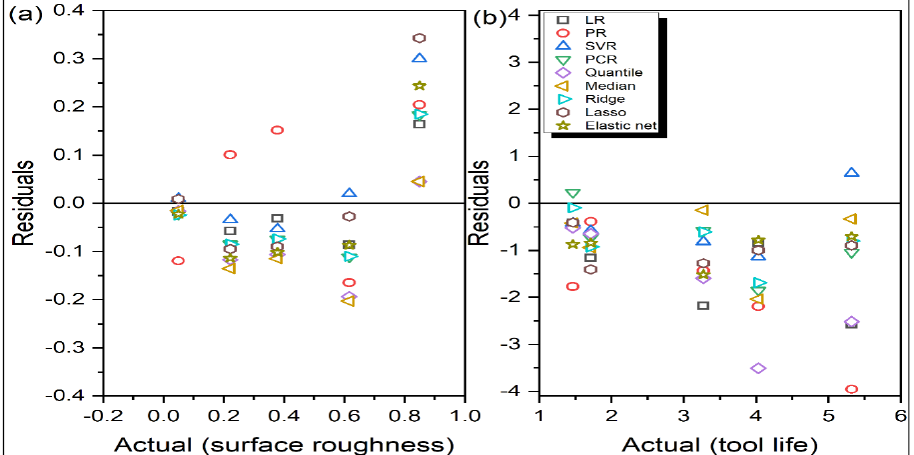
Figure 2. Actual responses versus residuals for turning ( a ) Ra ( b ) TL.